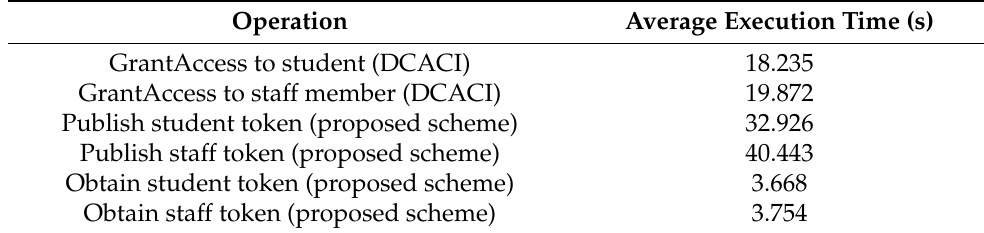
Table 5. Comparison with DCACI: average execution time of each